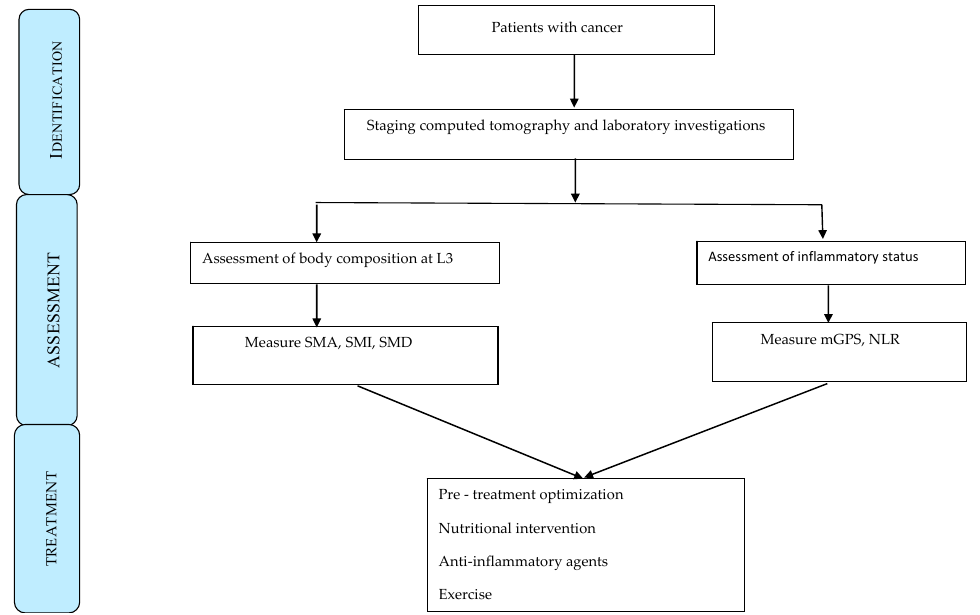
Figure 2. Management algorithm of pre-treatment assessment in patients with cancer. SMA = Skeletal muscle area, SMI = Skeletal muscle index, SMI = Skeletal muscle density, mGPS = modified Glasgow prognostic score, NLR = neutrophil lymphocyte ratio